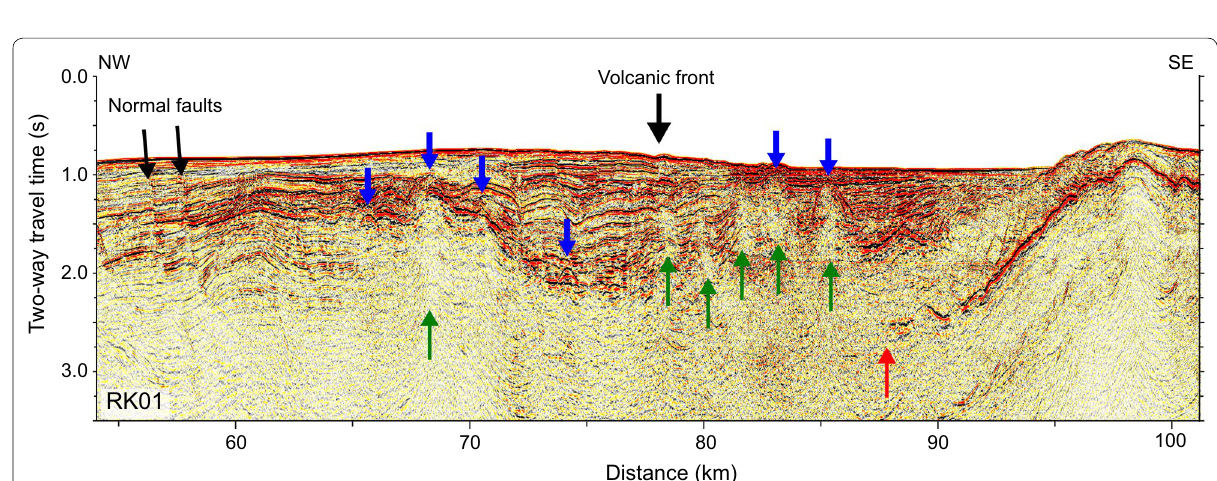
Fig. 5 Seismic reflection image showing “buried” magmatic intrusions along the RK01 profile. This image highlights tubular transparent bodies indi- cating volcanic conduits (shown by green arrows). Upwardly convex reflectors are interpreted to be sedimentary layers pushed up by the upwelling flow (blue arrows). The sudden disappearance of the high-amplitude reflector (acoustic basement) which is coincident with the distribution of the volcanic conduits (red arrow) also supports that the arc crust is highly disturbed by magmatic intrusions. On the western part of the basin, normal faults displacing the sedimentary layers are observed (black